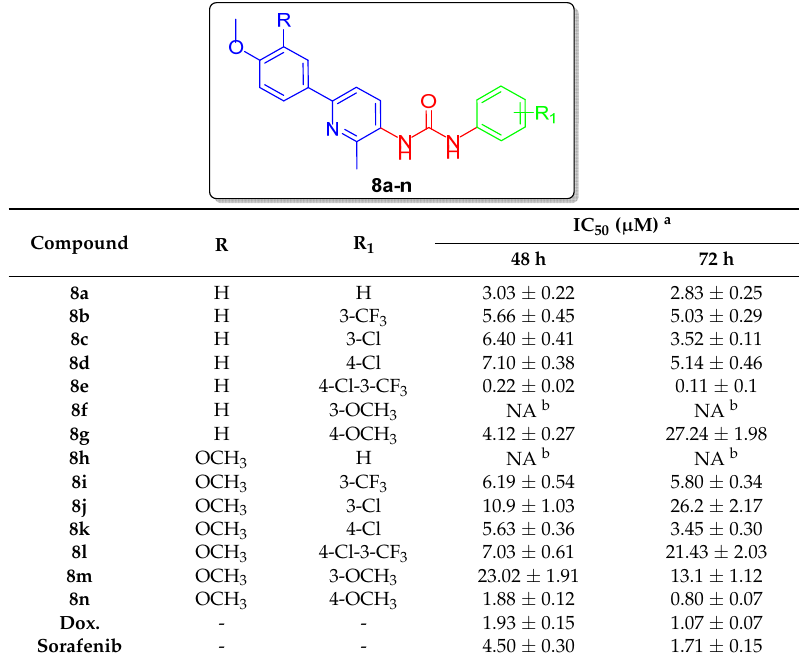
Molecules 2018 , 23 , x Table 1. In vitro anti ‐ proliferative activity of pyridine ‐ ureas 8a – n against MCF ‐ 7 breast cancer cell Table 1. In vitro anti-proliferative activity of pyridine-ureas 8a – n against MCF-7 breast cancer cell line.